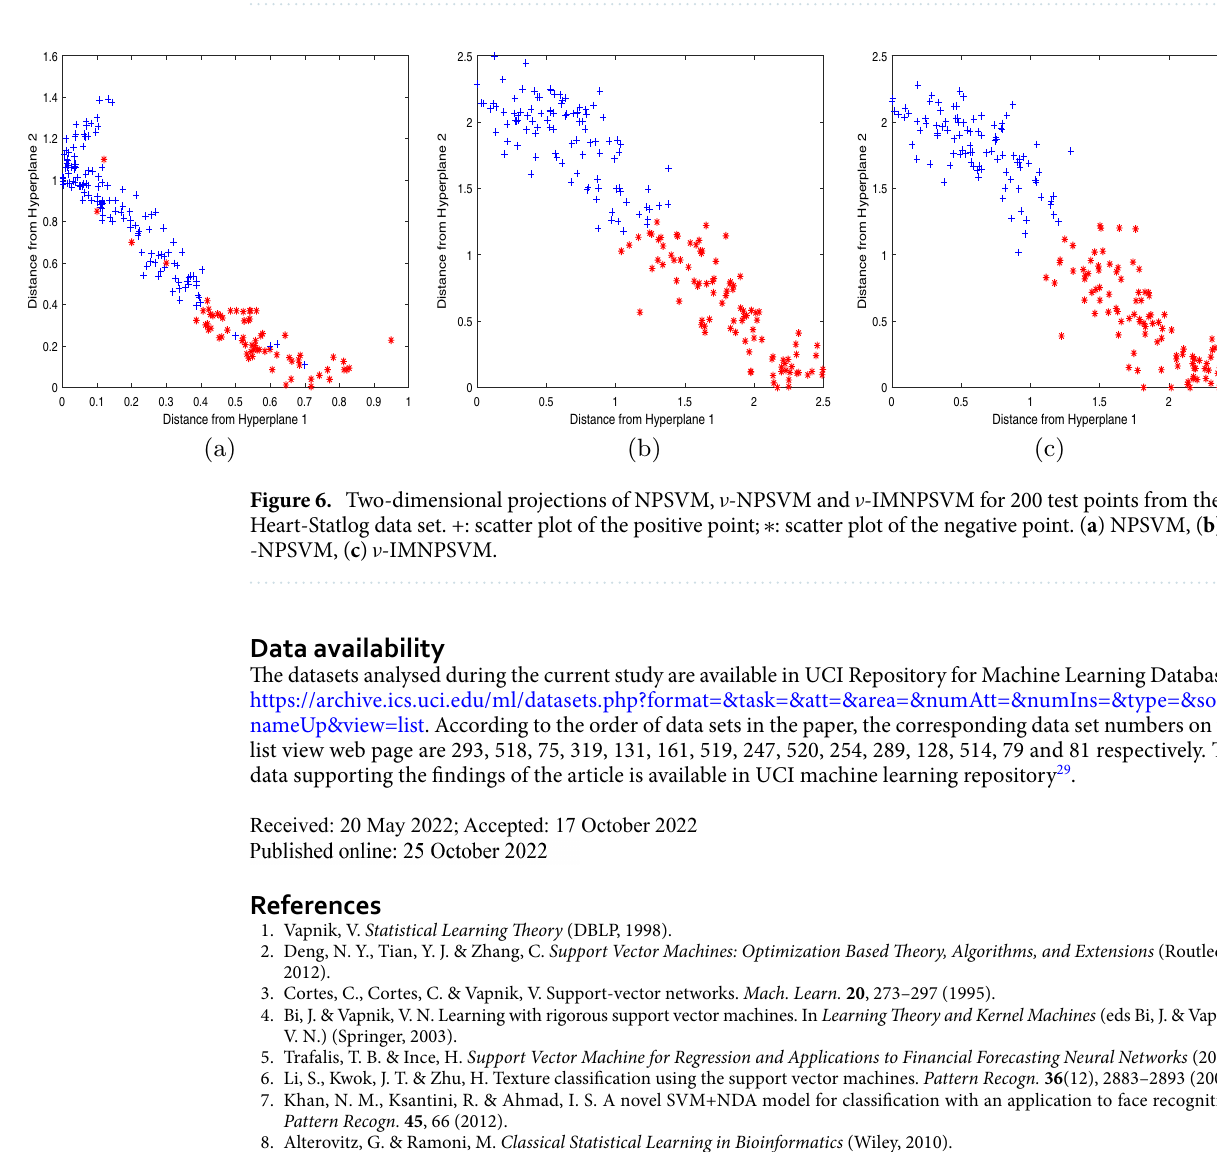
Figure 5. Two-dimensional projections of NPSVM, ν -NPSVM and ν -IMNPSVM for 200 test points from the BUPA liver data set. +: scatter plot of the positive point; ∗ : scatter plot of the negative point. ( a ) NPSVM, ( b ) ν -NPSVM, ( c ) ν -IMNPSVM.